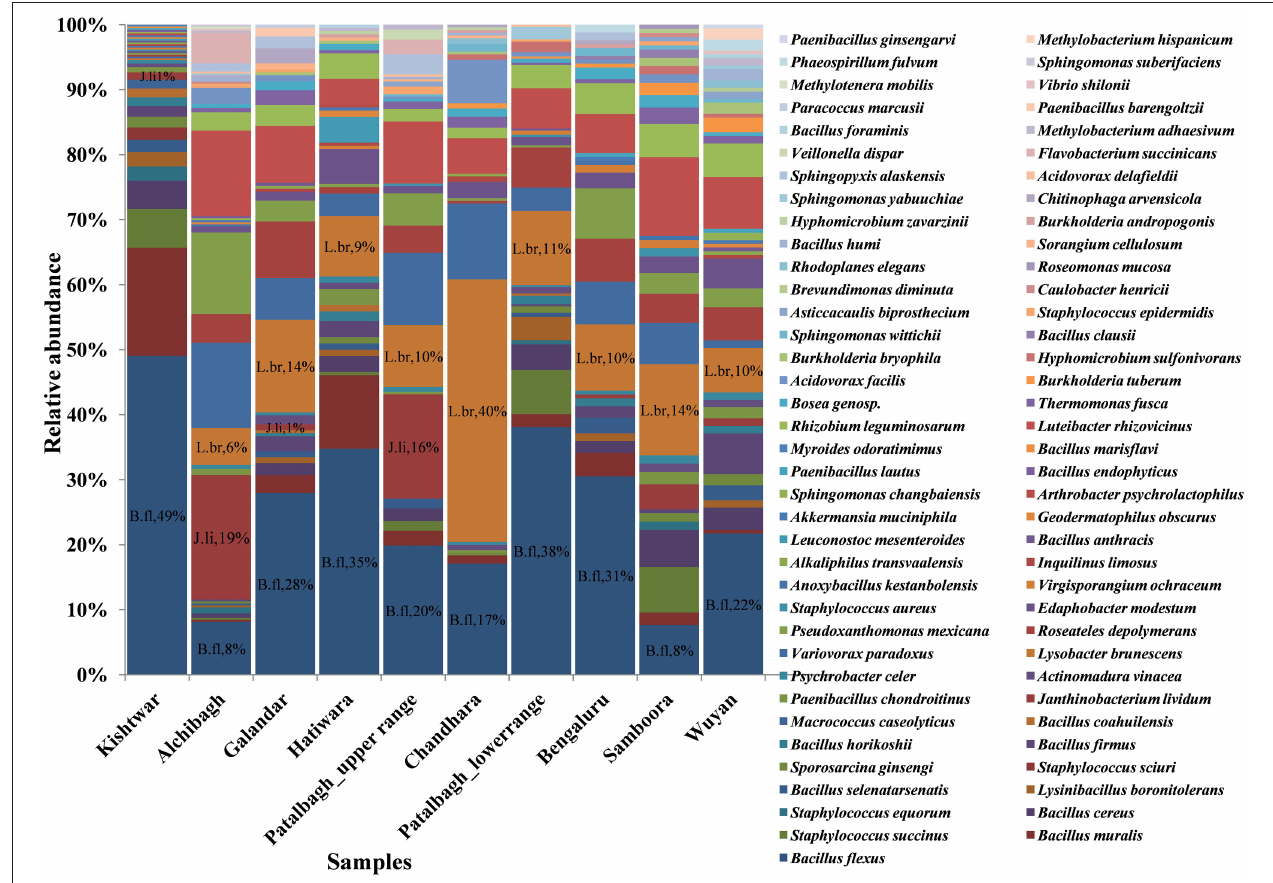
FIGURE 5 | Comparison of bacterial species in saffron rhizosphere from different geographical locations. The OTU cataloged up to species level were normalized to 2,000. A total of 73 species were cataloged from all the samples wherein Bacillus flexus (B. fl), Lysobacter brunescens (L. br), Janthiobacterium lividum (J. li) were found